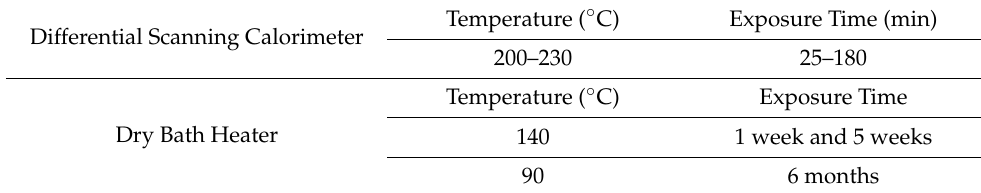
Table 2. Conditions of isothermal accelerated aging